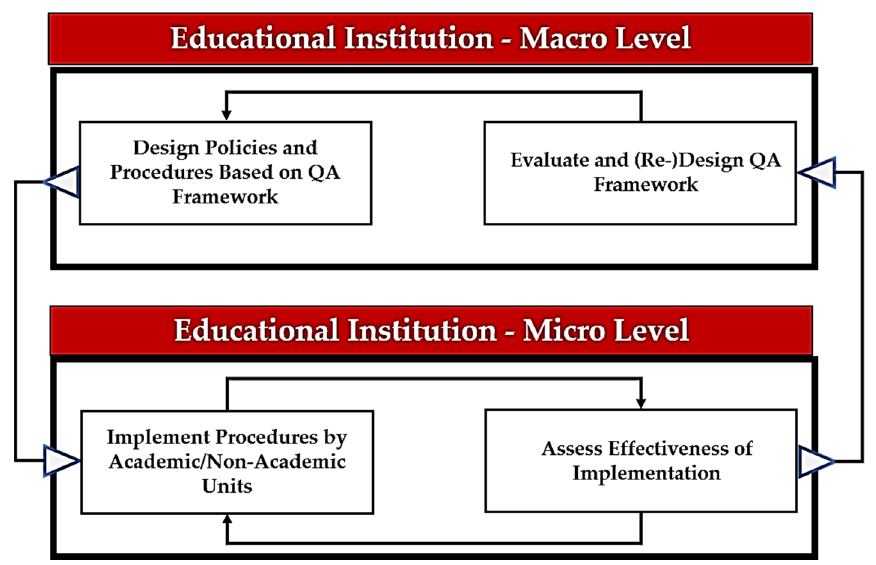
Figure 4 . The QA system and its continuous improvement cycle. Figure 4. The QA system and its continuous improvement